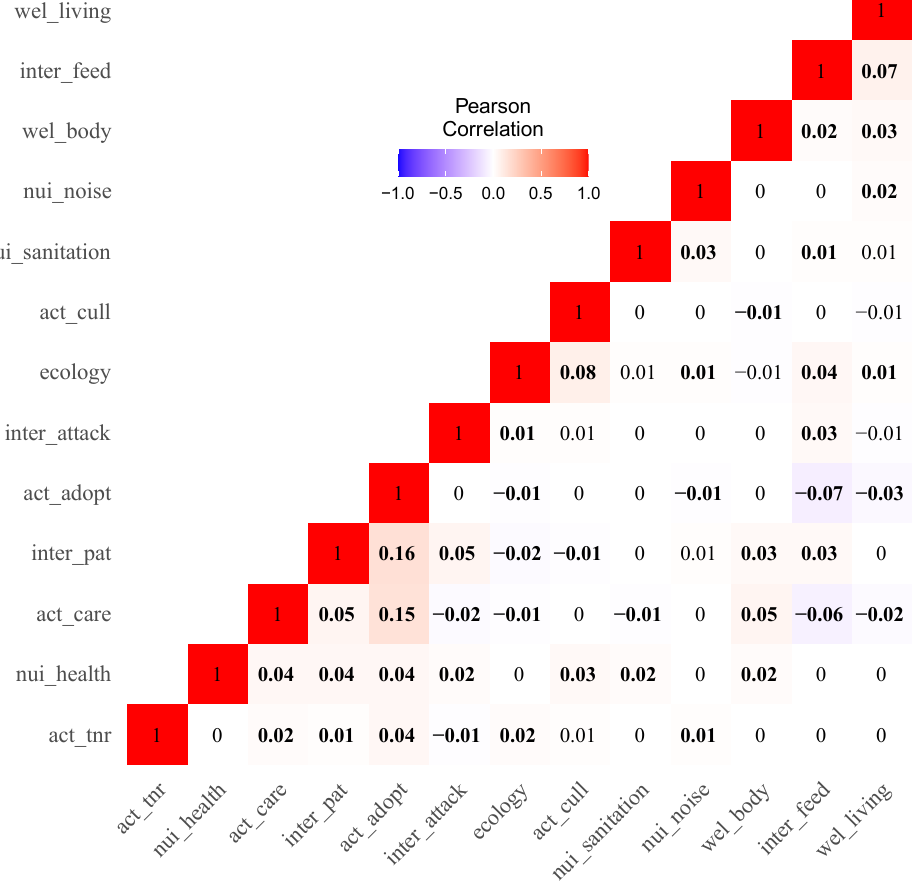
Figure 3. The correlation matrix of thirteen subtopics (Bold font highlights correlations with statistical significance, p < 0.05).